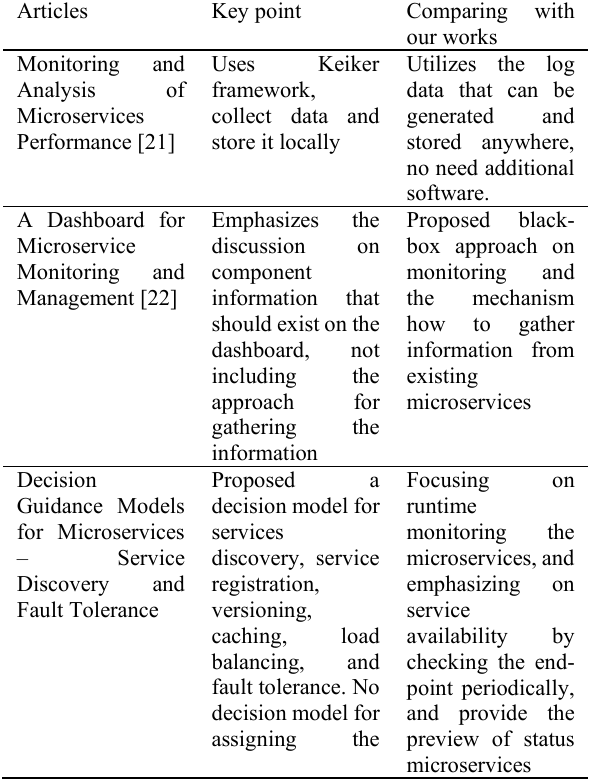
Table 4. Related Works on Monitoring